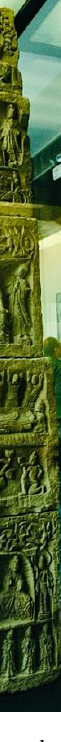
Figure 3. Zhuanglang Pagoda. Gansu Province. Early sixth century, Northern Wei. Gansu Provincial Museum. Photograph courtesy of Wang Xiaoshu.